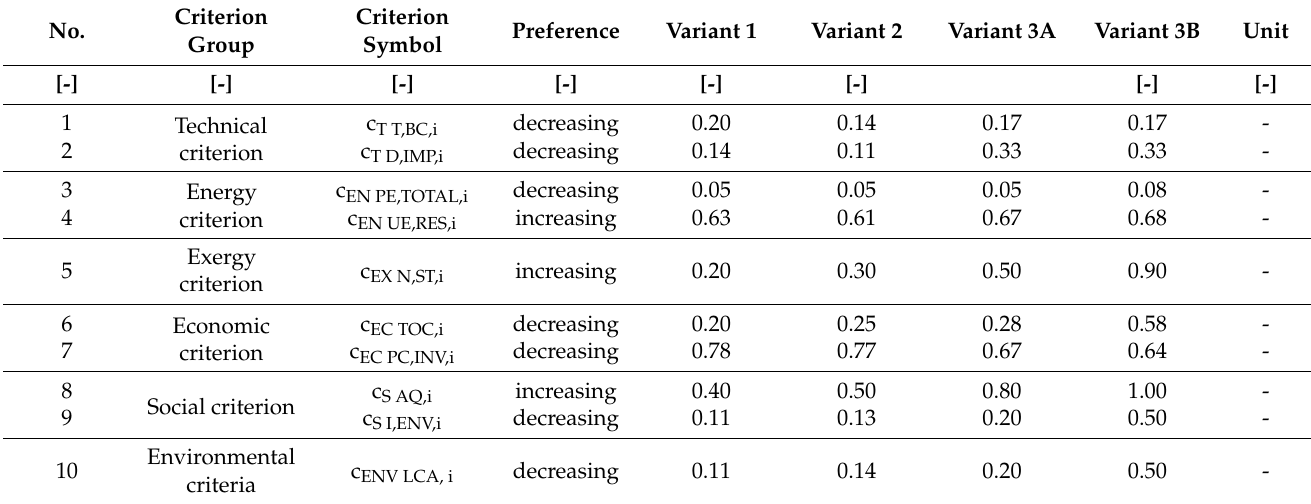
Table 8. Normalised values of indicators for selected evaluation sub-criteria.